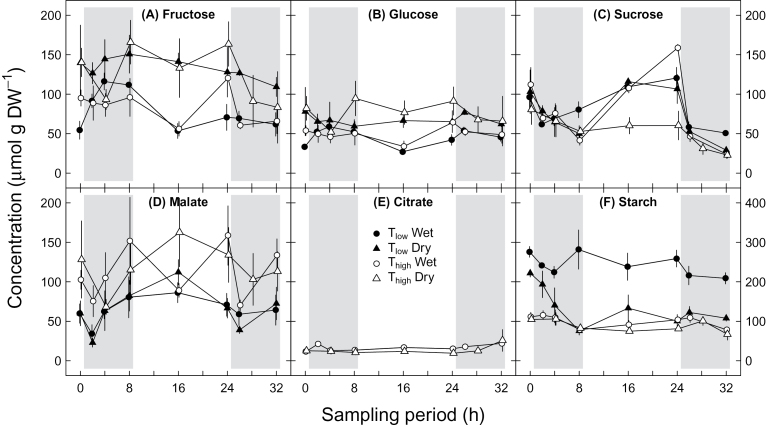
Daily cycles of the concentration of different leaf respiratory carbon sources under different environmental conditions during the sampling period: (A) fructose, (B) glucose, (C) sucrose, (D) malate, (E) citrate, and (F) starch. Potato plants were treated with a combination of Tlow (low temperature; closed symbols), Thigh (high temperature; open symbols), and wet (circles) or dry (triangles) conditions. Grey areas indicate nighttime. Results for fructose are affected by co-elution with other compounds. To facilitate comparison with other metabolites, sucrose concentrations were multiplied by 2 to count for hexose units, while starch concentrations are given in molarity of starch monomers. Note different y-axis scale in (F). Means ±SE are given (n=2–3).